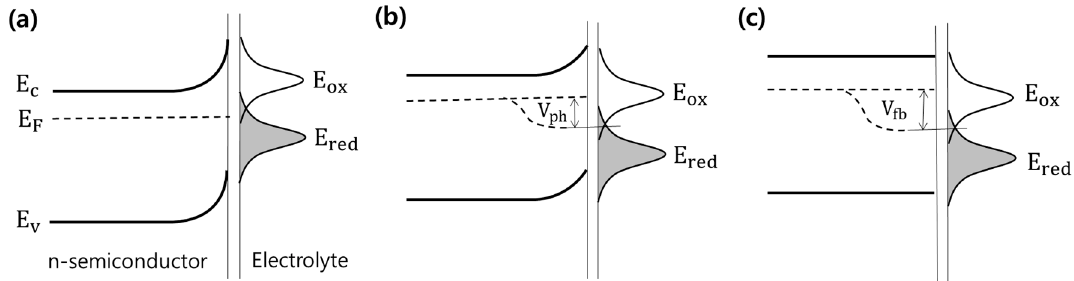
Figure 6. ( a ) Dark equilibrium condition of the n -type Si photoanode immersed in an electrolyte. The Fermi level is aligned with the redox potential of the electrolyte. ( b ) Photovoltage induced under illumination by creating quasi-Fermi level. ( c ) Flat-band potential ( V fb ) is the potential at which the band bending flattens under sufficiently intense illumination.